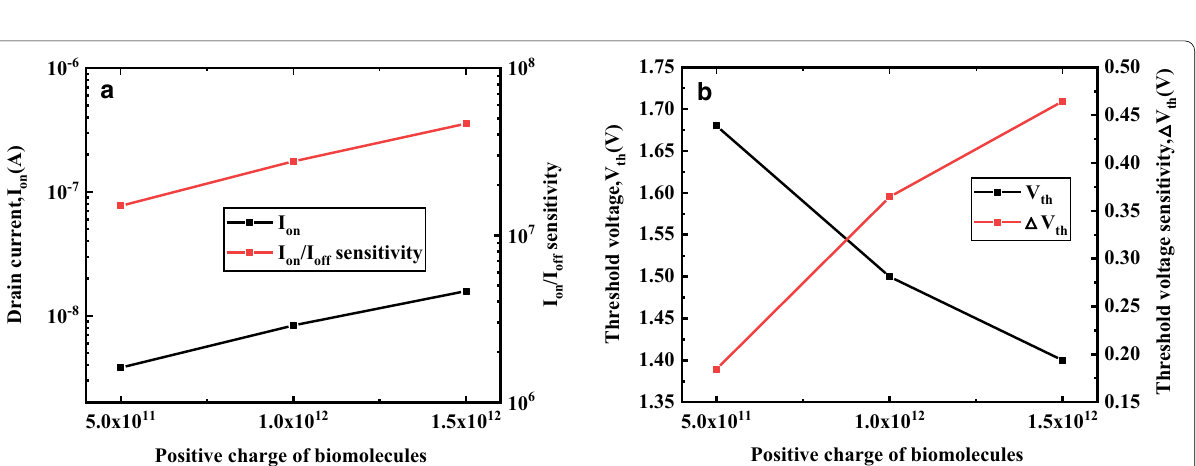
Fig.9 a Effect of different positive charge of biomolecules on I on , I on / I off sensitivity, b V th and △ V th of DM-DSTGTFET at V g and T c 5 =